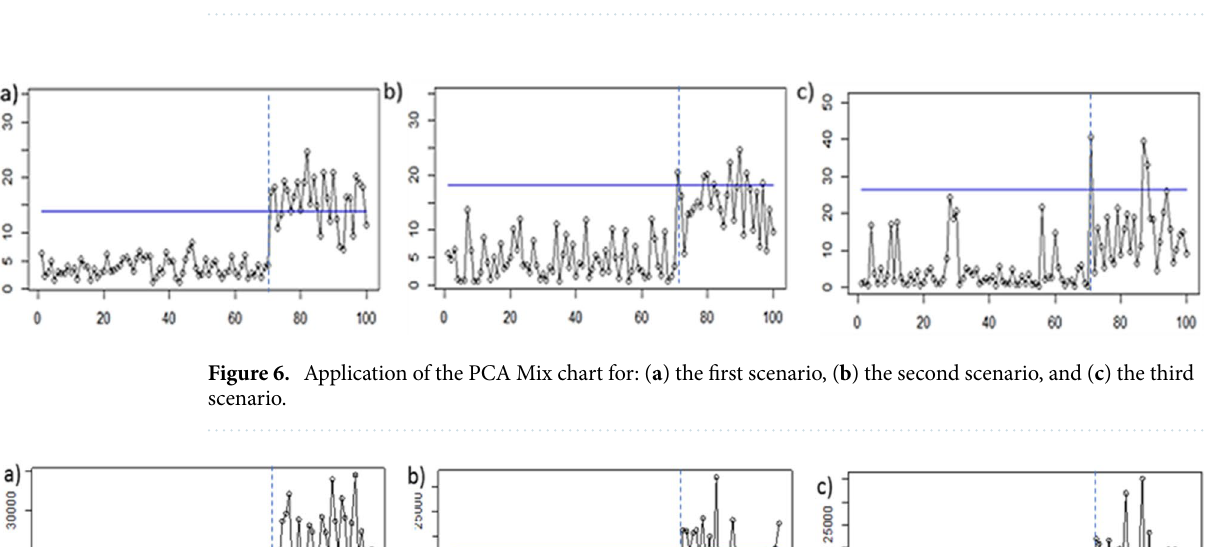
Table 5. Scenarios of simulated data for proposed chart application.